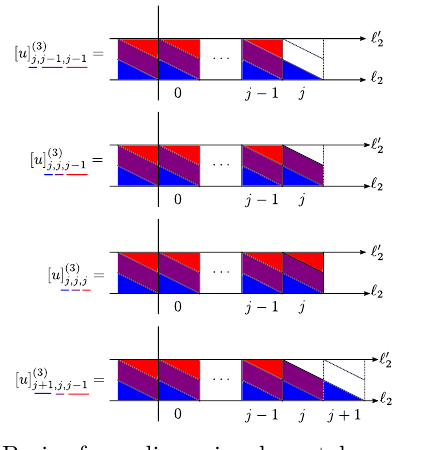
(b) Coordinates of atoms.